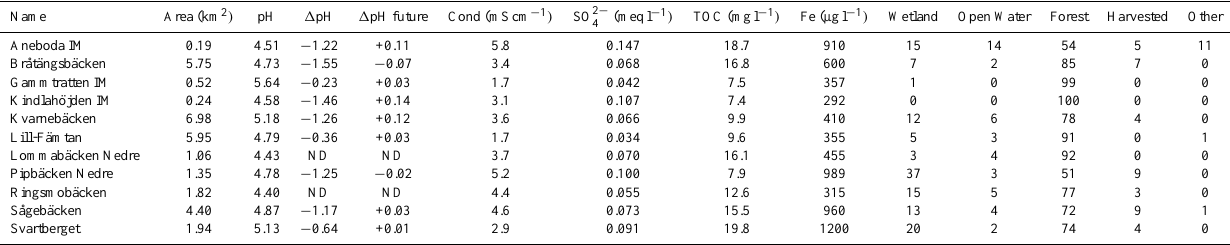
Table 2. Selected site parameters (medians), land use (% area), estimated anthropogenic acidification ( 1 pH) since 1860, and future expected recovery ( 1 pH future) for each stream by 2030, except where no data (ND) is